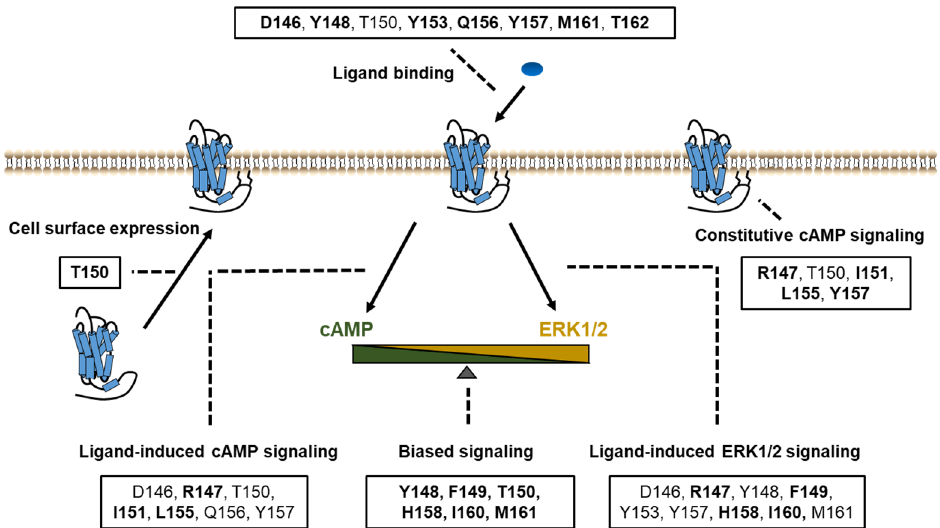
Figure 7. Summary of the functions of the DRYxxI motif and ICL2. Impaired cell surface expression, ligand binding, and/or signaling pathways were due to alanine mutations of the residues shown in boxes. The residues indicated in bold font, are thought as critical residues for the relevant function of receptors, on which alanine mutations primarily cause defective